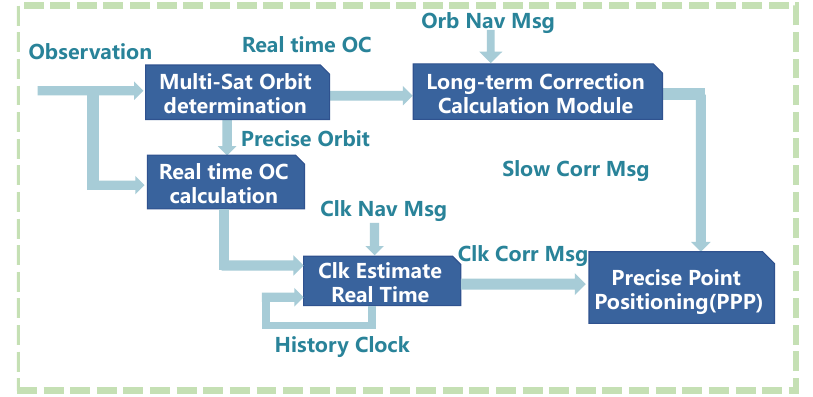
Figure 4. Reconstructed PPP-B2b clock offset estimation